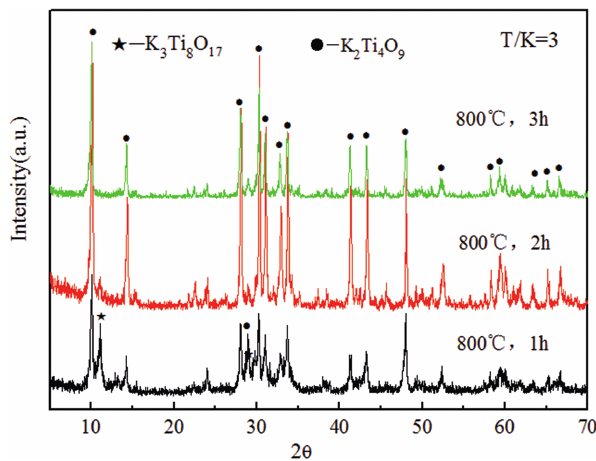
Figure 6: XRD patterns of samples with different holding times calcined at